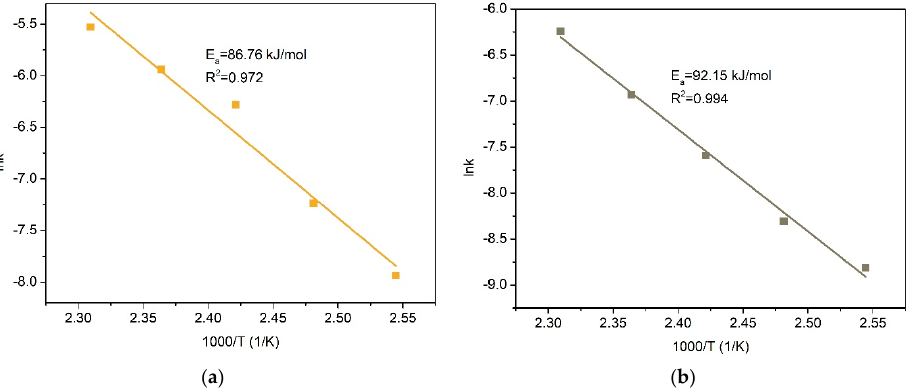
Figure 8. Dependence of lnk − 1000/T for the recovery of copper ( a ) and silver ( b ) into solution from a desilicated concentrate.